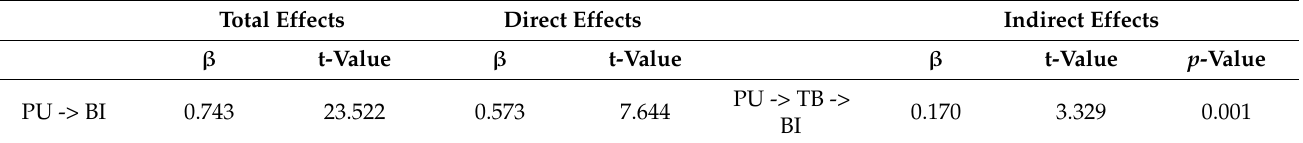
Table 8. Mediation analysis (Complete